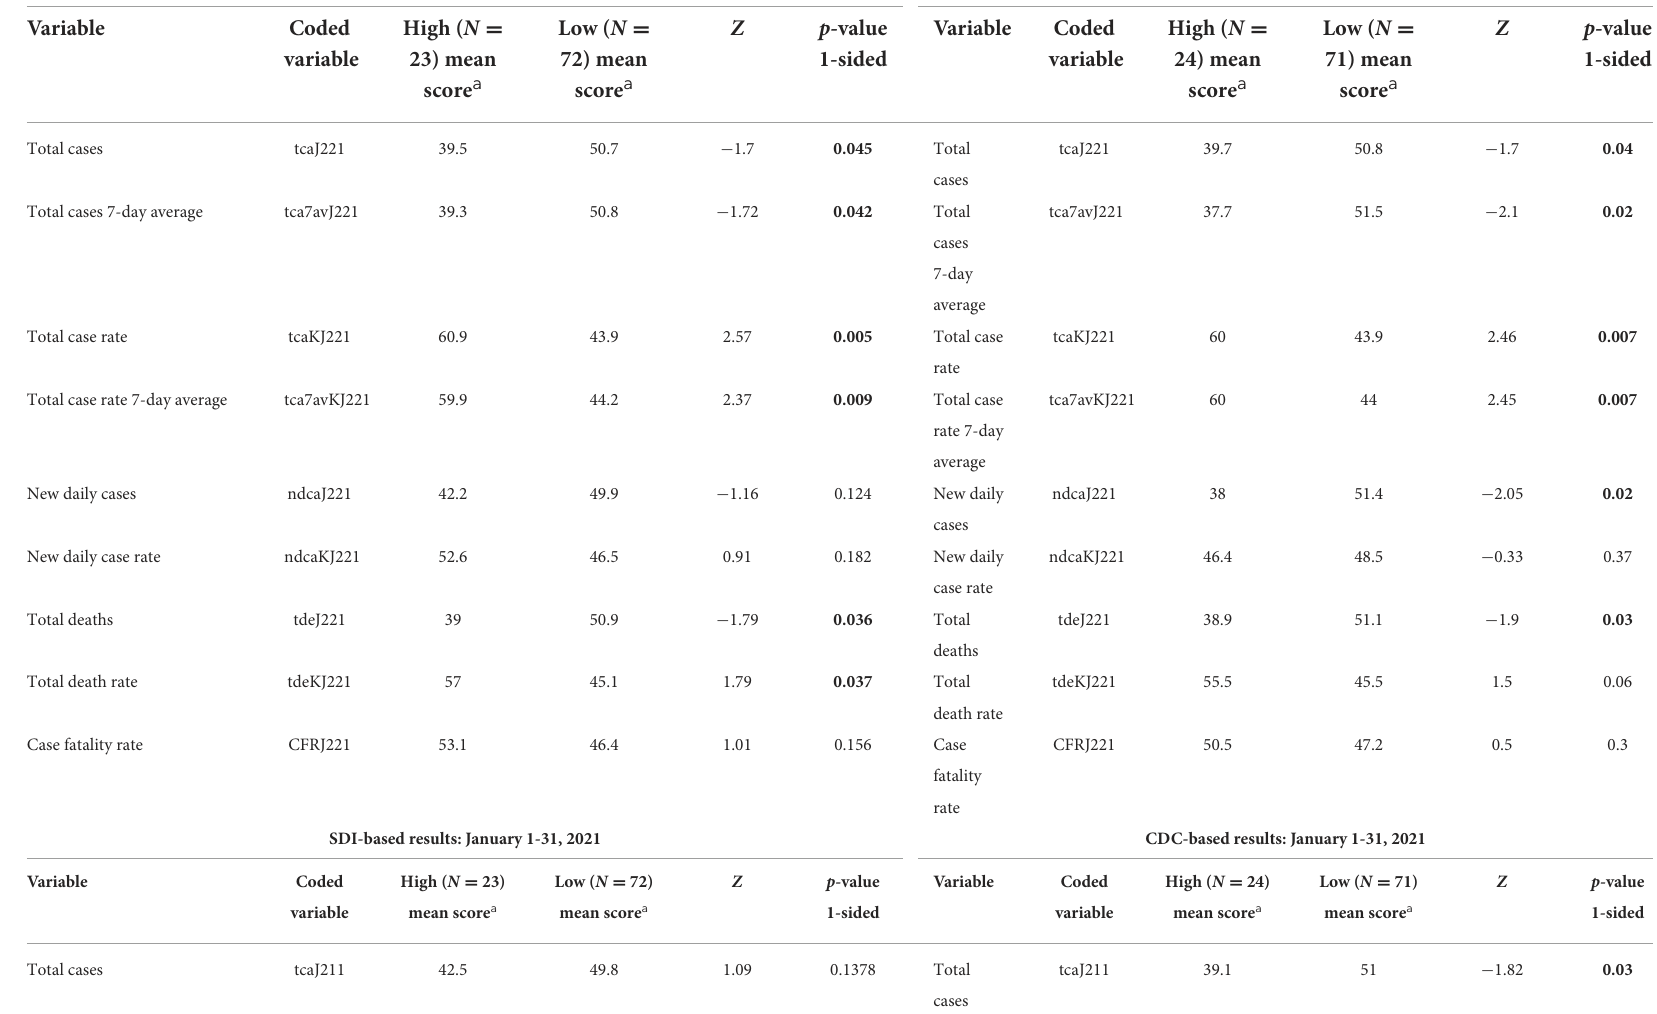
TABLE 2 The results of Wilcoxon Two-Sample Test (1-sided) using January 1, 2022 (top of the table) and January 1, 2021 (bottom)